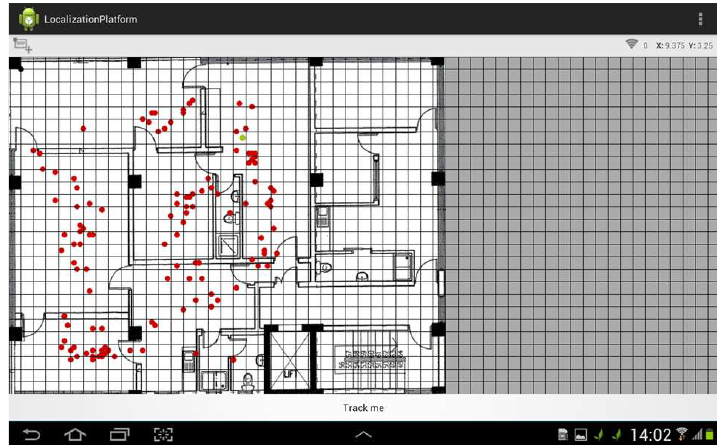
Figure 3. φ map and localization platform.